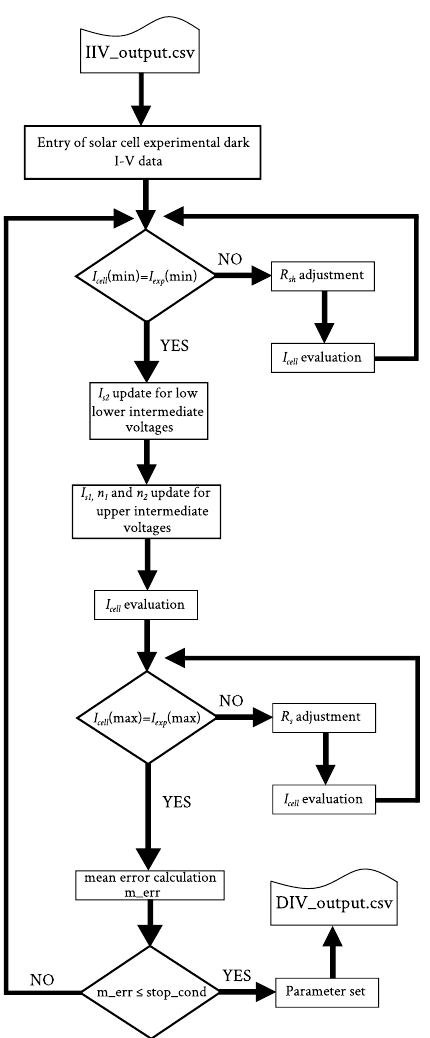
Figure 5. Flow diagram of the DIVf